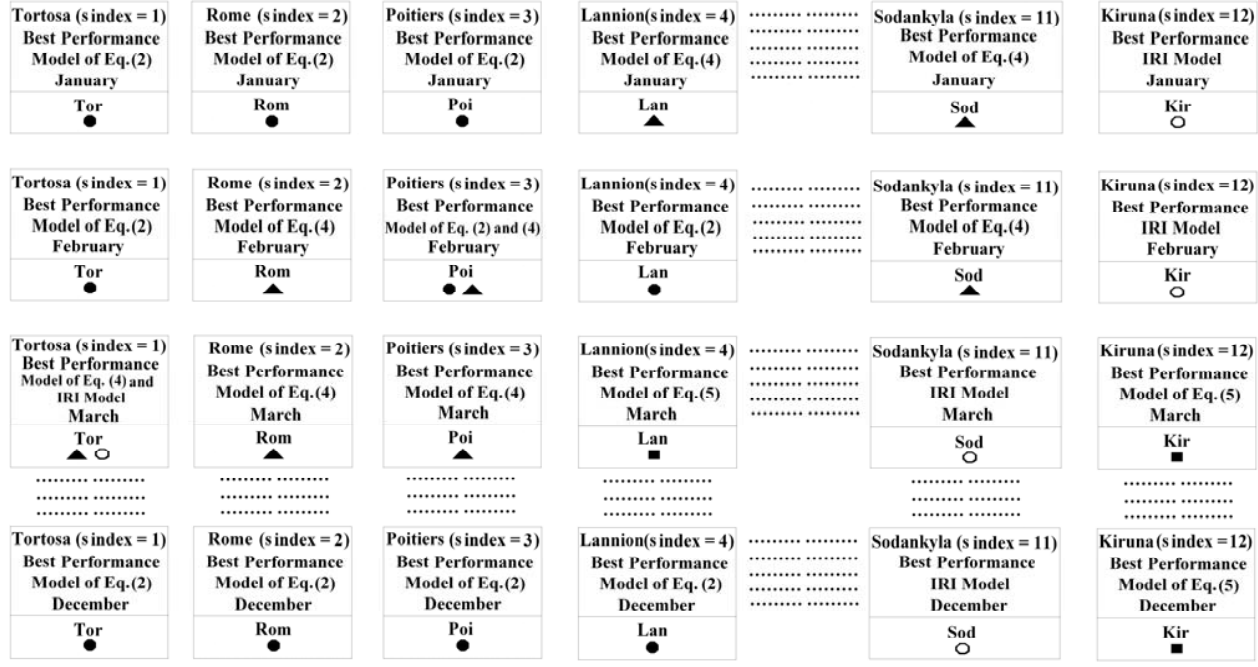
Fig. 3. Example of models providing the best performance (marked with a different symbol) for some ionospheric observatories and for some months, under moderate geomagnetic